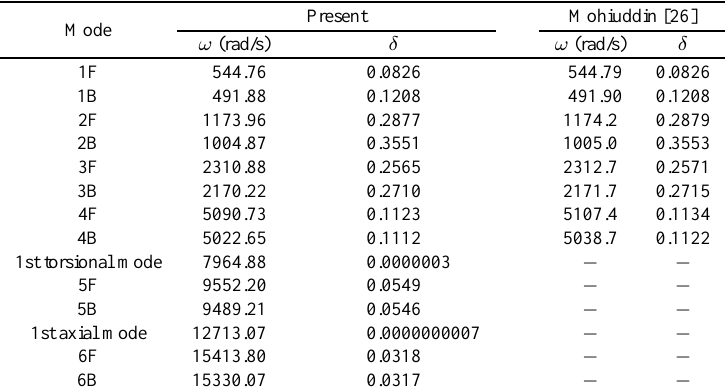
Table 3 The comparison of damped frequencies of the rotor system of Example